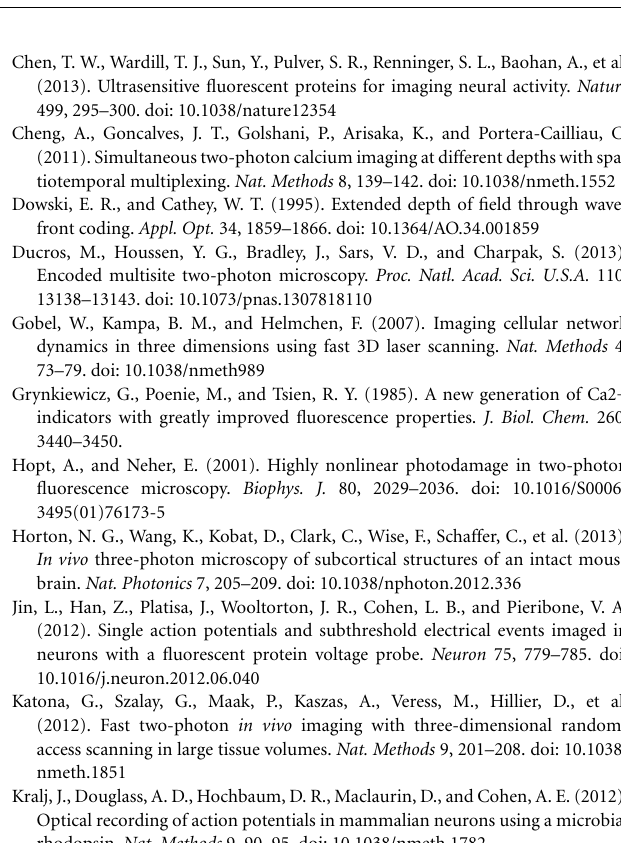
FIGURE 8 | Axial dependence of the imaging PSF vs. depth in scattering tissue. Characterization of the imaging performance of volume projection imaging using GCaMP6s labeled tissue at P31 in white matter tissue. GCaMP6s was chosen to provide near uniform labeling throughout the tissue. (A) A focused spot was translated axially via a mechanical stage and the resulting collected intensity is reported, yielding a mean scattering length of the incident illumination ( λ = 920nm) of